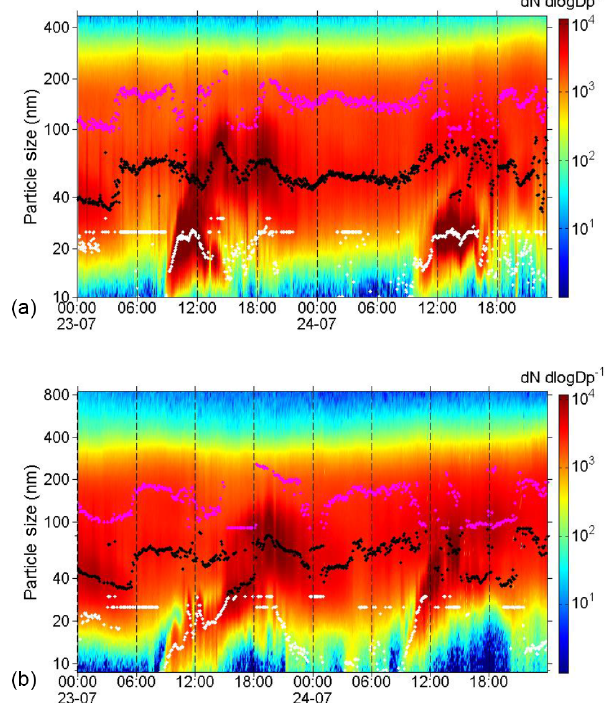
Figure 8. Diurnal evolution of the aerosol size distribution on 23 and 24 July (EF) at Santorini (top panel) and Finokalia (bottom panel). The white dots stand for nucleation, the black dots for Aitken, and the purple dots for accumulation geometric mean di-